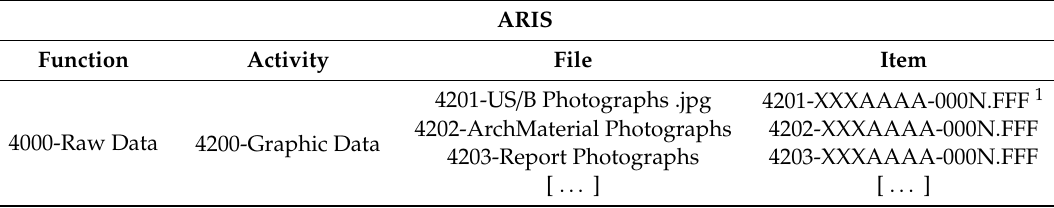
Table 1. Primary management of archaeological record. Item file classification and